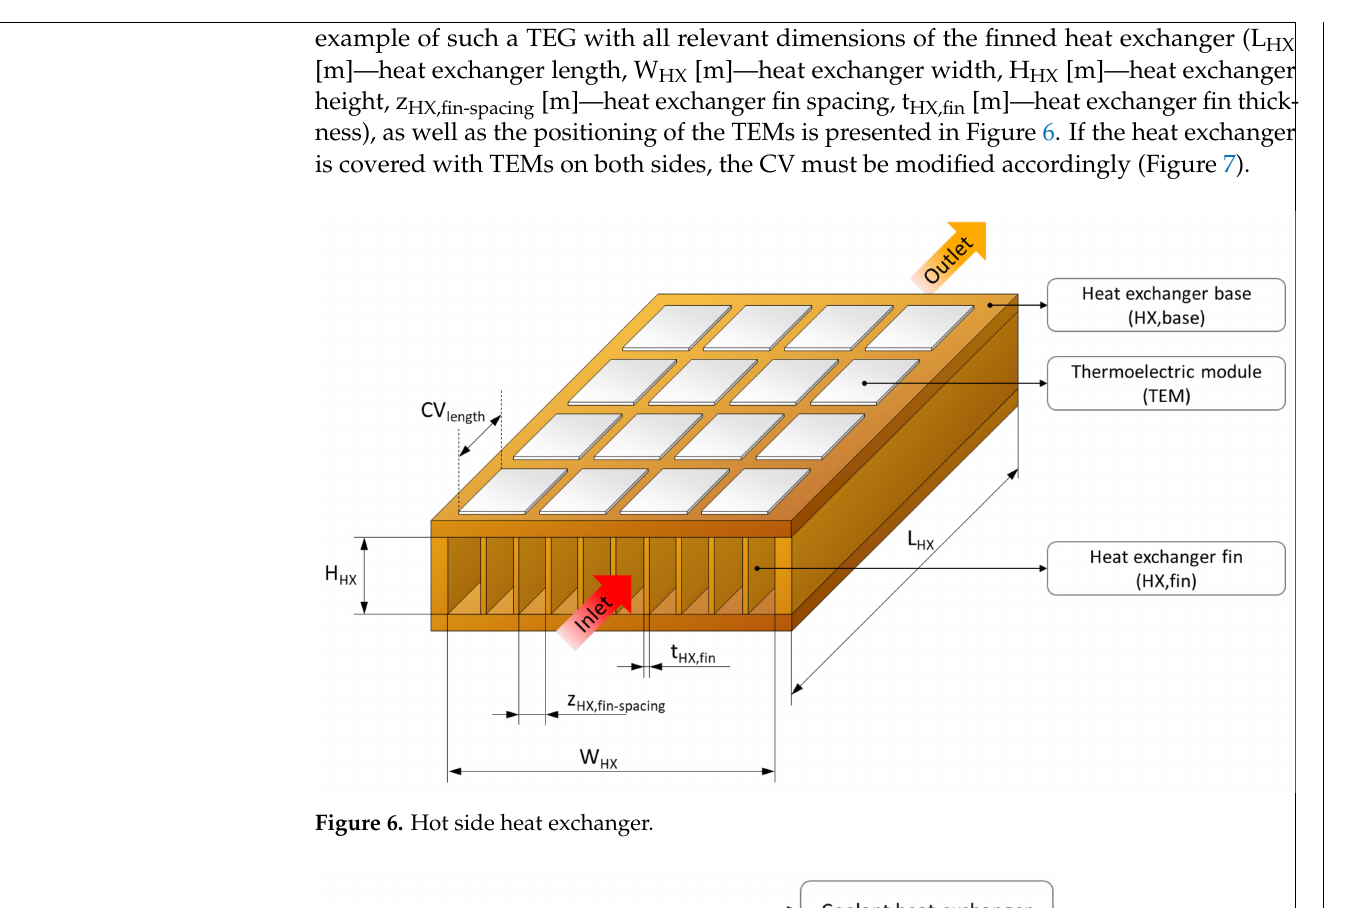
Figure 6. Hot side heat exchanger.